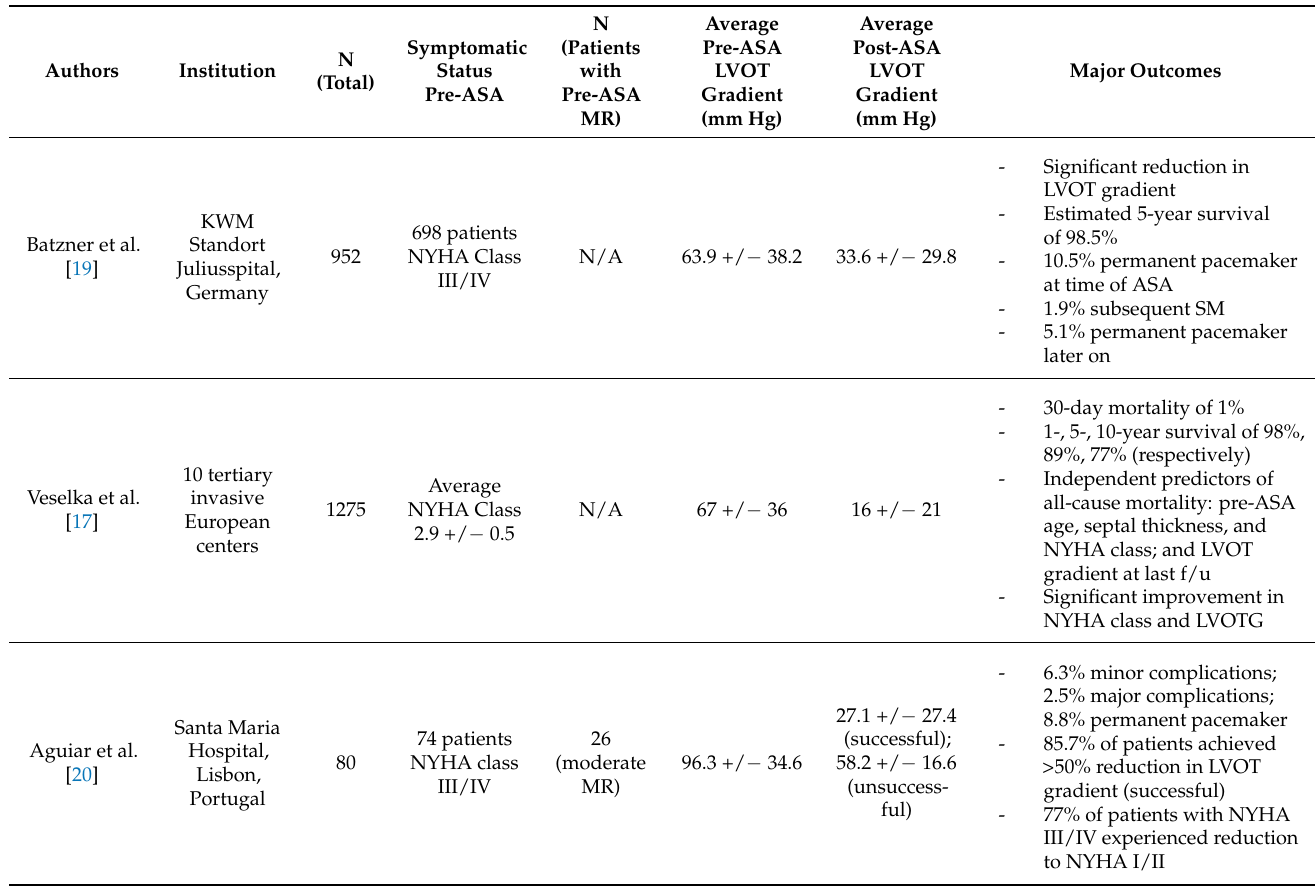
Table 1. Summary of the salient characteristics and results of studies on alcohol septal ablation for the treatment of hypertrophic obstructive cardiomyopathy discussed in this